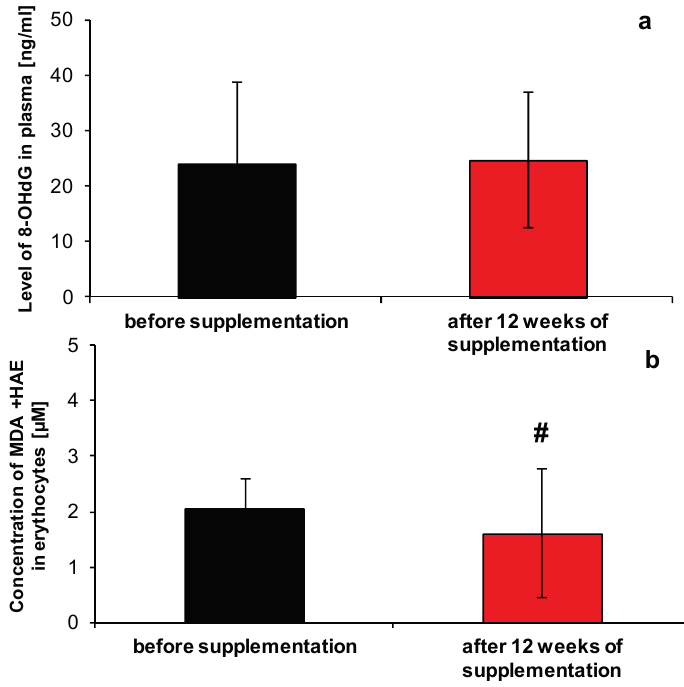
Figure 2. Oxidative stress biomarkers in blood samples of women before and after micronutrient supplementation with NucleVital ® Q10 Complex; lipid peroxidation markers in erythrocytes ( a ), plasma ( b ) and level of 8-OHdG ( c ). # indicates statistically significant differences p <